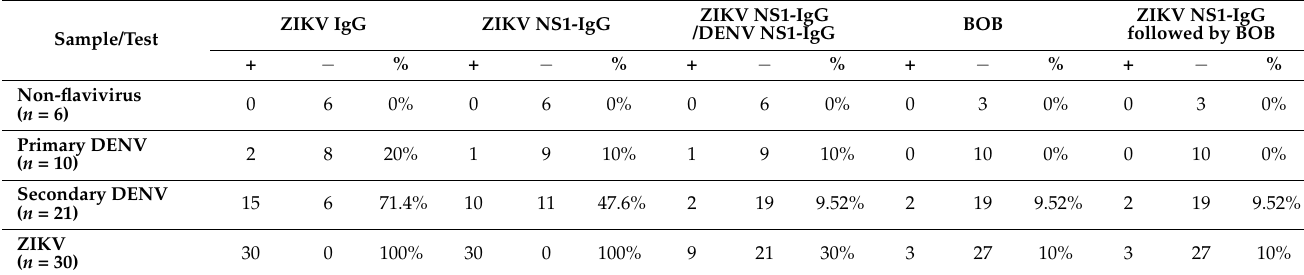
sample divided by the average OD 450 of the negative sample. Table 1. Results of enzyme-linked immunosorbent assays in various serum